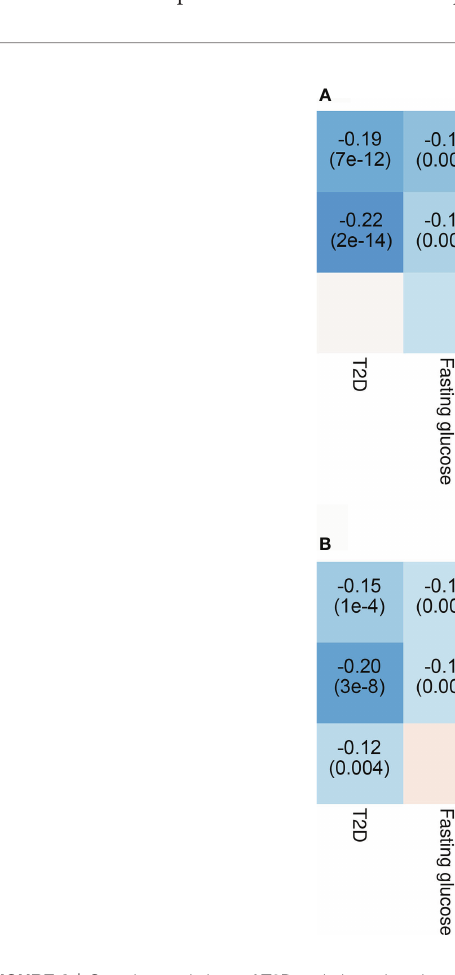
FIGURE 2 | Genetic correlations of T2D and glycemic traits with pulmonary function. Shown are the results from LD score regression with data (A) for T2D from DIAGRAM consortium (N = 807,553), for glycemic traits from MAGIC (N = 10,701 – 123,665), and for pulmonary function from SpiroMeta consortium (N = 79,055) and data (B) for T2D from DIAGRAM consortium (N = 69,033), for glycemic traits from MAGIC (N = 10,701 – 123,665), and for pulmonary function from UK Biobank (N = 345,665 – 353,315). Colors represent the effect estimates (as measured by r G ) between two inherited traits, and r G with corresponding p -values are only displayed for genetic correlation with p < 0.05. Red indicates positive genetic correlation, and blue indicates negative genetic correlation. FEV1, forced expiratory volume in 1 s; FVC, forced vital capacity; HbA1c, hemoglobin A1c; LD, linkage disequilibrium; T2D, type 2